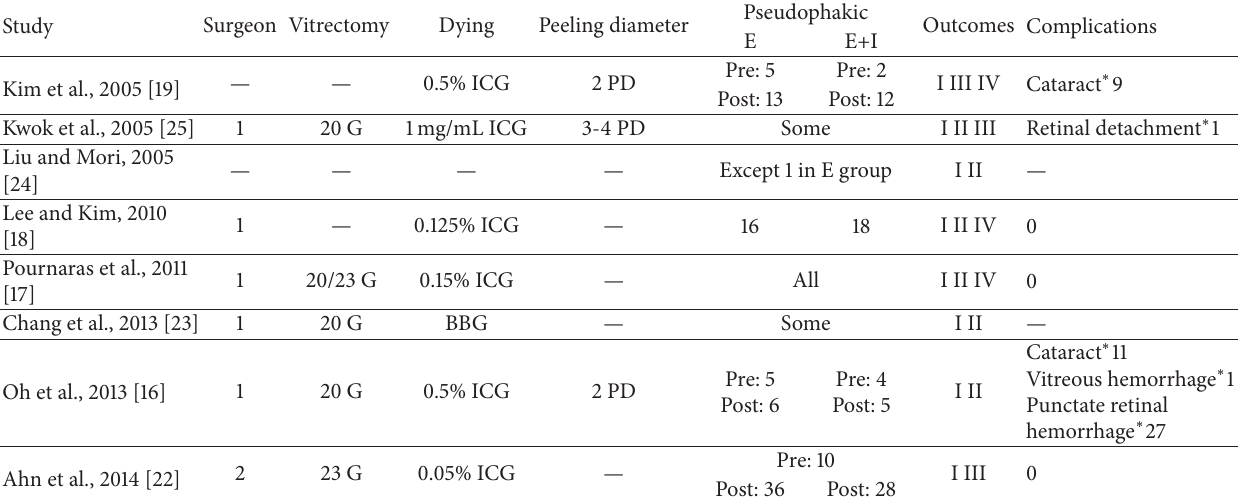
Figure 2: Visual outcomes of patients who underwent idiopathic retinal membrane peeling (IERM) only and those who underwent IERM + internal limiting membrane peeling. (a) Best-corrected visual acuity ≤ 6 months after surgery; (b) best-corrected visual acuity between 6 and 12 months after surgery; (c) best-corrected visual acuity in 18th month after surgery; (d) best-corrected visual acuity > 6 months after surgery; (e) rate of improvement in visual acuity—by ≥ 2 Snellen lines; (f) recurrence rate. Table 3: Surgery-related features of the included